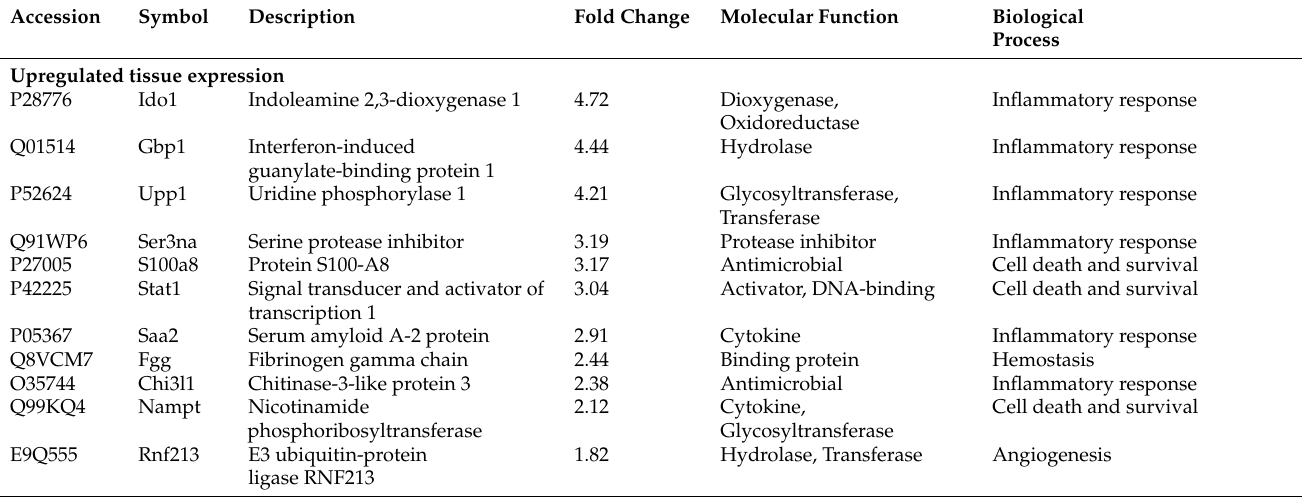
Figure 2. An outline of the proteomics analysis. ( A ) Summary of proteins differing between the two time points and groups; ( B ) Heat map showing the relative abundance and clustering of the 86 proteins identified across all four groups; ( C ) Principal component analysis (PCA) of the samples in the syngeneic group post-transplant day 3 (open circle) and day 6 (closed circle), and in the allogenic group at post-transplant day 3 (open square) and day 6 (closed square); ( D ) Volcano plot illustrating the fold change (log base 2) in protein expression in relation to the p -value ( − log base 10) between non-rejecting (syngeneic) vs. rejecting (allogenic) grafts at day 6. Each dot represents a protein. Proteins at a significance level greater than 0.01 are in blue, those with a log2 fold change less than − 2 and greater than 2 are in green, while proteins fulfilling both thresholds are in red, and their names are displayed. Table 1. List of proteins in the rejecting allografts with an altered protein expression relative to that found in syngeneic, non-rejecting grafts at the same time point (post-transplant day 6) as identified by iTRAQ-based